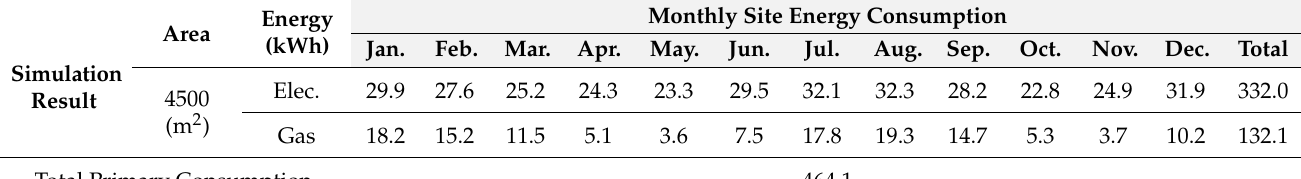
Table 4. The EnergyPlus simulated data (primary energy consumption values) for the base